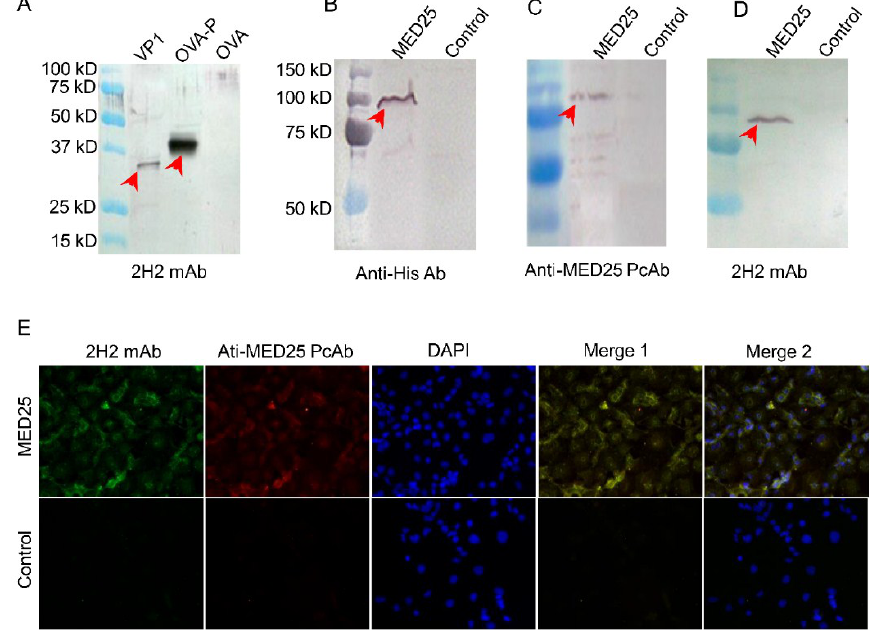
Figure 3. Reactivity of 2H2 to MED25 and common epitope. ( A ) Cross-reactivity of the 2H2 mAb against the common epitope. 2H2 mAb was generated using the common peptide (PPGAPKP) coupled on OVA. The cross-reactivity was detected by Western blot. 1 μg VP1, 5 μg OVA-P and 5 μg OVA were loaded on the gel. 2H2 mAb was used at a final concentration of 2 μg/mL. Specific bands are indicated by the red arrows. OVA, vector; OVA-P, vector with the common epitope peptide; ( B ) The lysate of 293T cells transfected with MED25 expression vector was stained by anti-His, cells were transfected with the empty expression vector as a control. MED25 was probed by these antibodies in an independent Western blot experiment, and 10 5 cells lysate was loaded in each cell on gel. Specific band is indicated by the red arrow; ( C ) The lysate was stained by anti-MED25 commercial polyclonal antibody, and the other conditions were the same as panel B; ( D ) The lysate was stained by 2H2, and the other conditions were the same as panel B; ( E ) 293T cells transfected with MED25 expression plasmid and empty plasmid (control), respectively, were indirectly stained with 2H2 (FITC, green) and anti-MED25 (rhodamine, red) antibodies. The nuclei were stained with DAPI (blue). Merge 1: green + red. Merge 2: green + red + blue. The isotype antibody was included as the control to monitor specific staining. Images were obtained at a magnification of